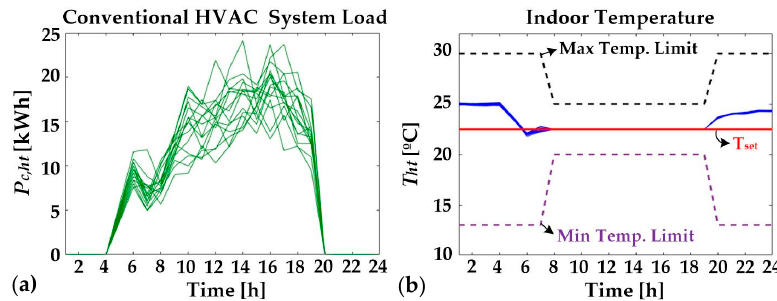
Figure 5. ( a ) Time-varying power inputs of the conventional (or, equivalently, price-inelastic) HVAC